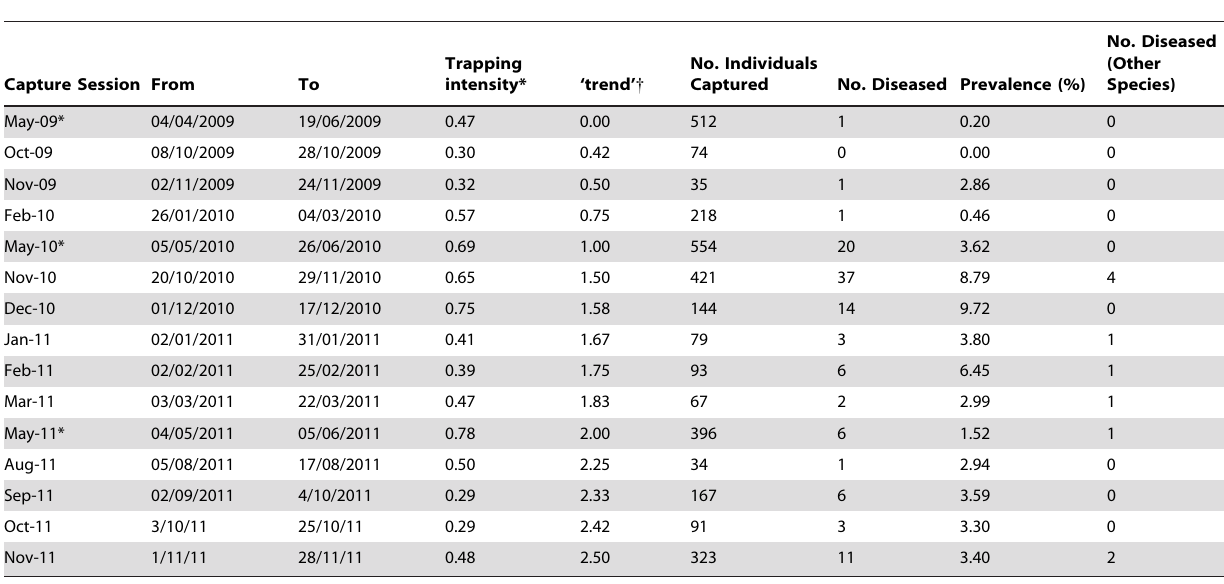
Table 1. Details of the capture sessions of great tits in Wytham Woods (May 2009–November 2011).